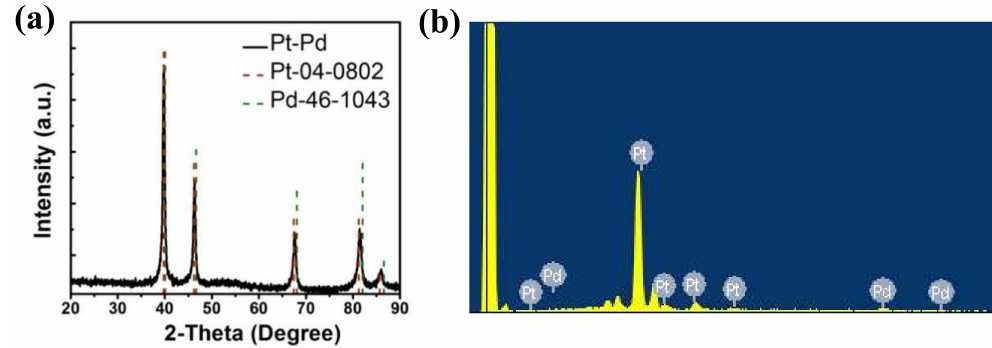
Figure 2. Composition analyses for the porous Pt–Pd nanoparticles synthesized at 190 ◦ C: ( a ) XRD spectrum and ( b ) energy-dispersive spectroscopy (EDS)